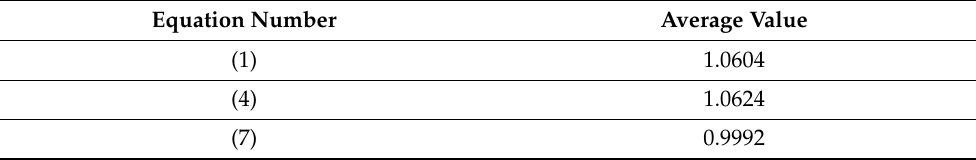
Table 5. Average Values of the Ratio of Calculated Value to Test